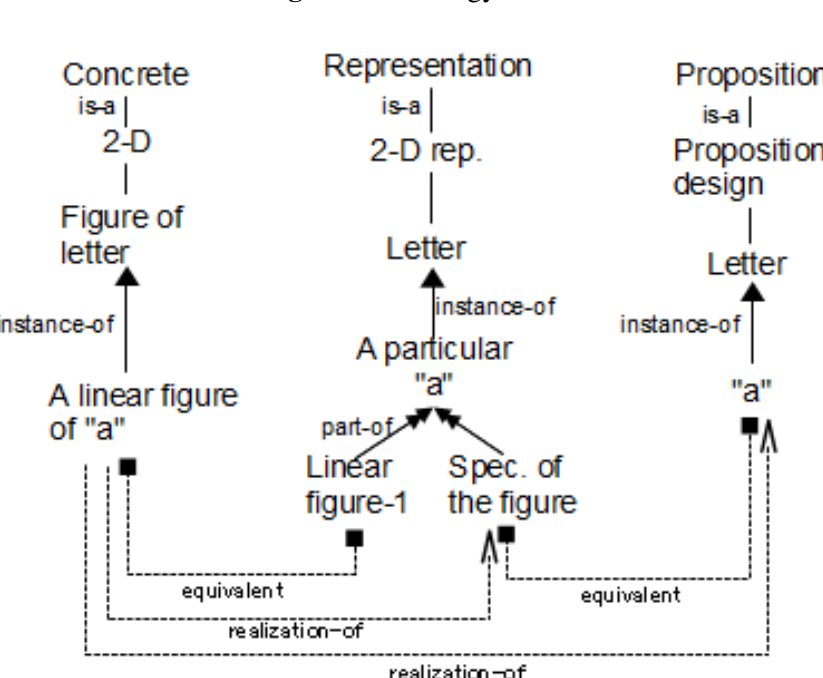
Figure 1. Ontology of